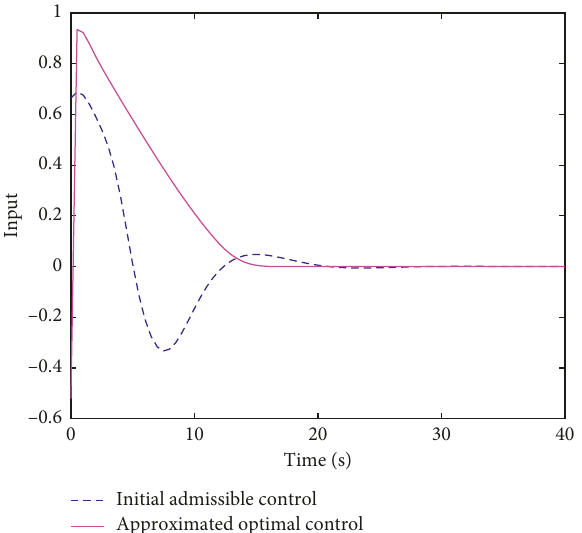
Figure 4: Trajectory of C A driven by initial admissible control and approximated optimal control.